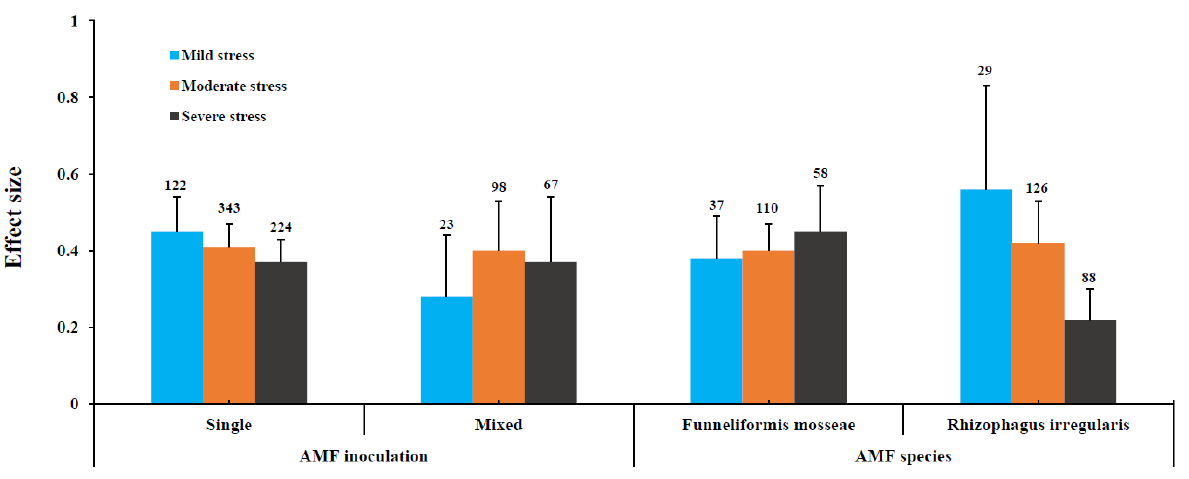
Figure 5. Categorical analysis of AMF inoculation and AMF species under different levels of stress.